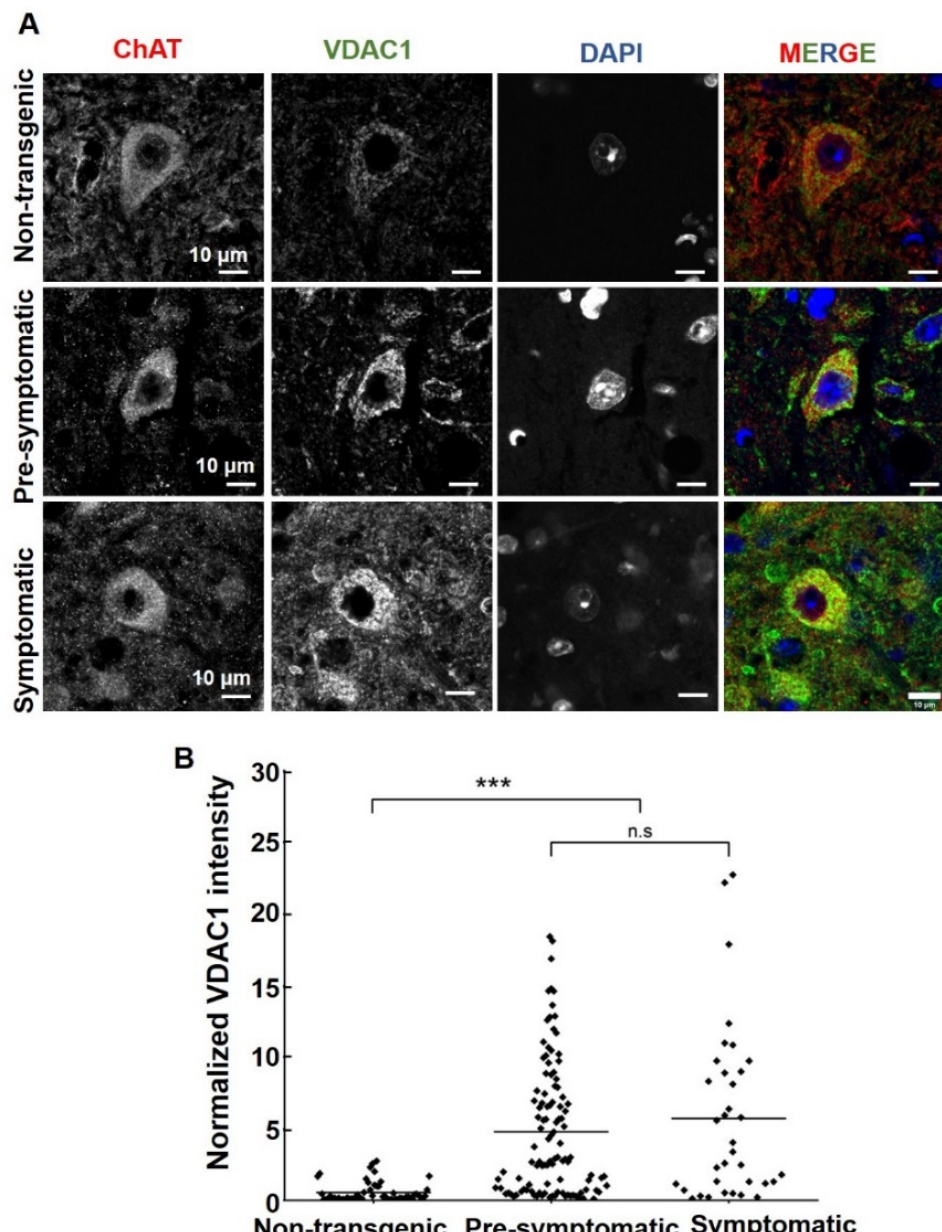
Figure 4. VDAC1 expression levels are increased in mutant SOD1 G93A spinal motor neurons. ( A ) Representative micrographs of paraformaldehyde-fixed paraffin-embedded lumbar spinal cord sections from non-transgenic, pre-symptomatic, and symptomatic mutant SOD1 G93A mice, co- immunofluorescence stained with the anti-ChAT antibody to detect motor neurons and anti-VDAC1. Cell nuclei were stained by DAPI. Scale bar = 10 µ m. ( B ) Quantification of the relative fluores- cence intensity of VDAC1 staining of lumbar spinal cord from non-transgenic, pre-symptomatic, and symptomatic mutant SOD1 G93A mice was calculated using NIS Element AR 5.21.03 software. About three different sections from three different mice of each group were analyzed. Statistics were calculated using OriginPro2022. Horizontal lines represent mean values for each group. p -values were determined using a Kruskal–Wallis test. *** p < 0.001; ns = non-significant. This suggests that the increase in VDAC1 expression in spinal motor neurons of pre- symptomatic mice is due to increased VDAC1 levels per mitochondria and not an increase in the total amount of